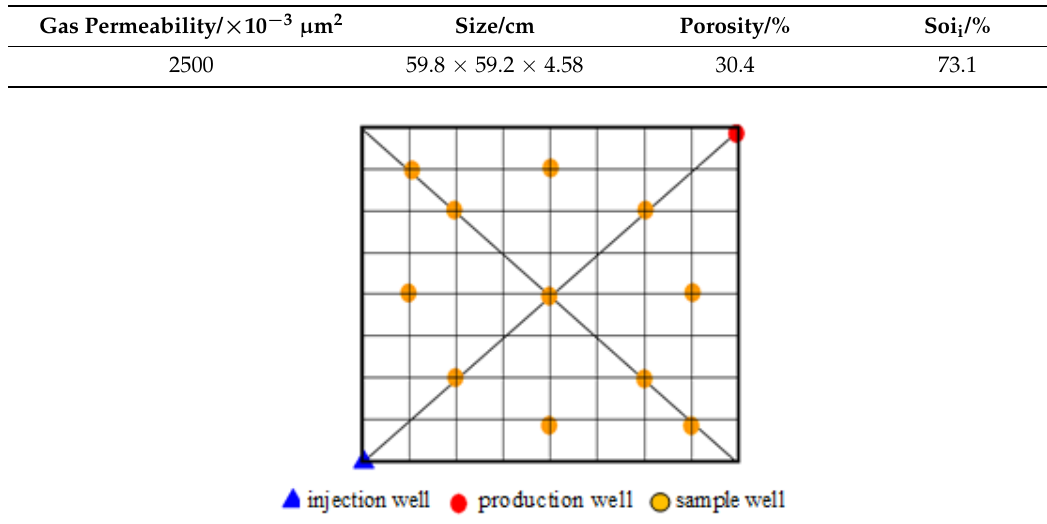
Figure 3. The well spacing pattern.